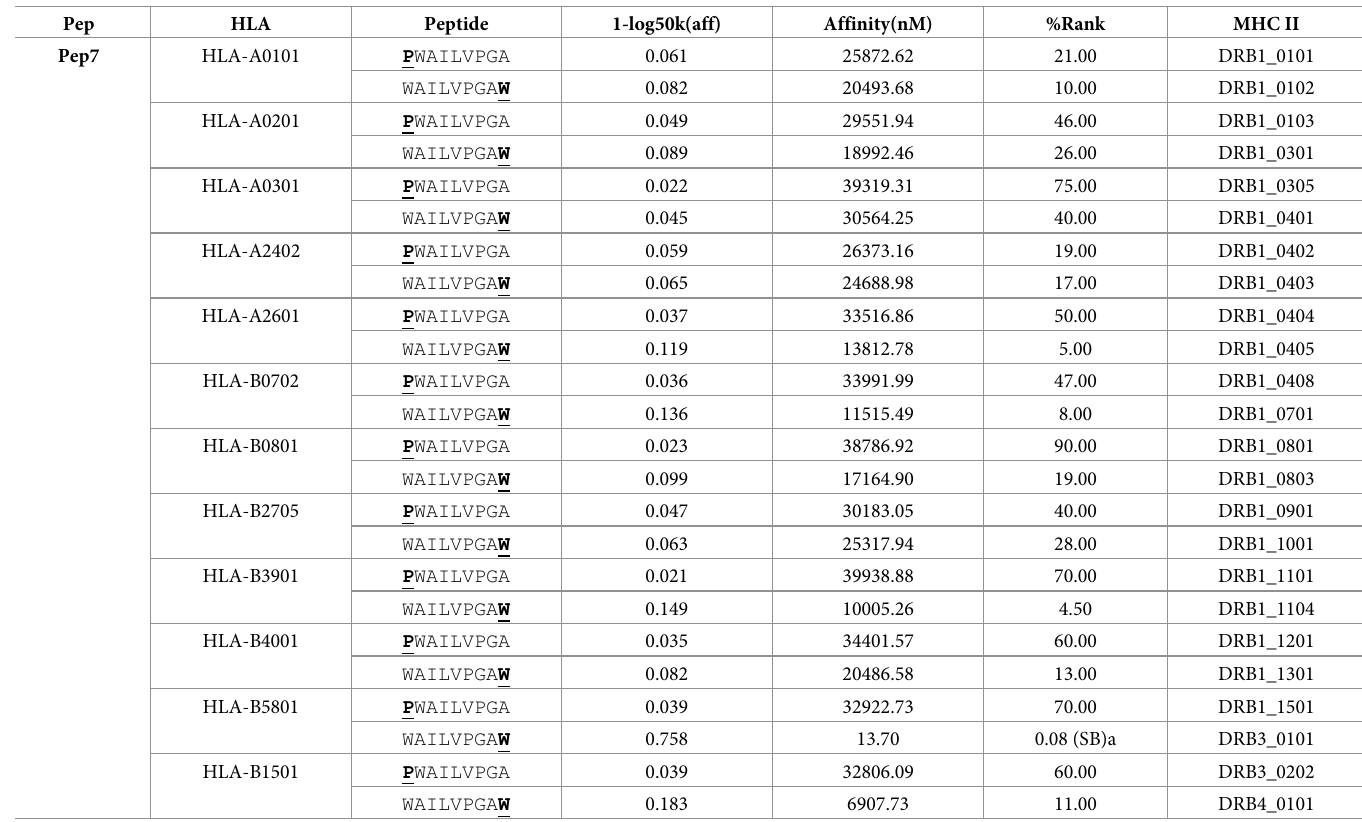
Table 1. Peptide 7 binding capacities against MHC I and II